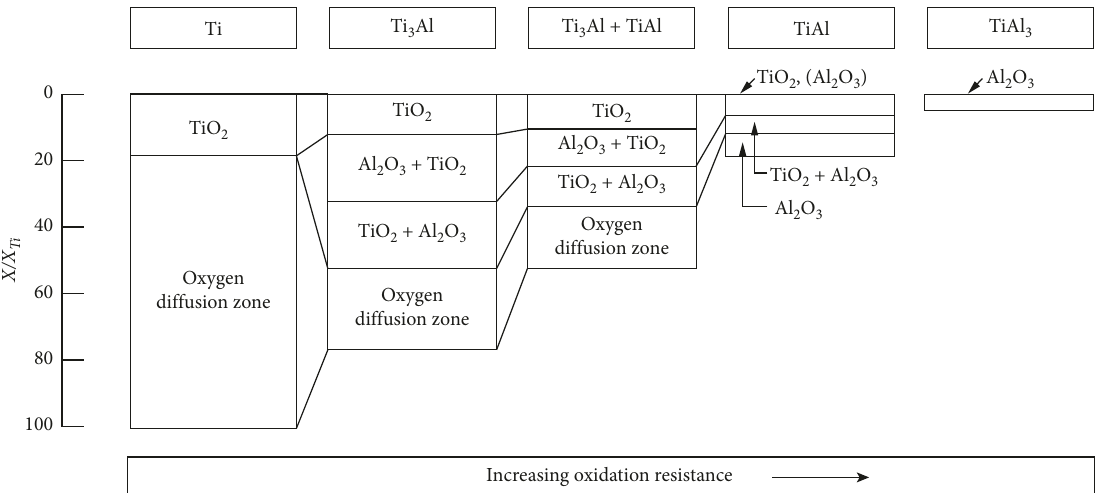
Figure 15: Schematic representation of oxide scales and oxygen diffusion zones of titanium-based alloys